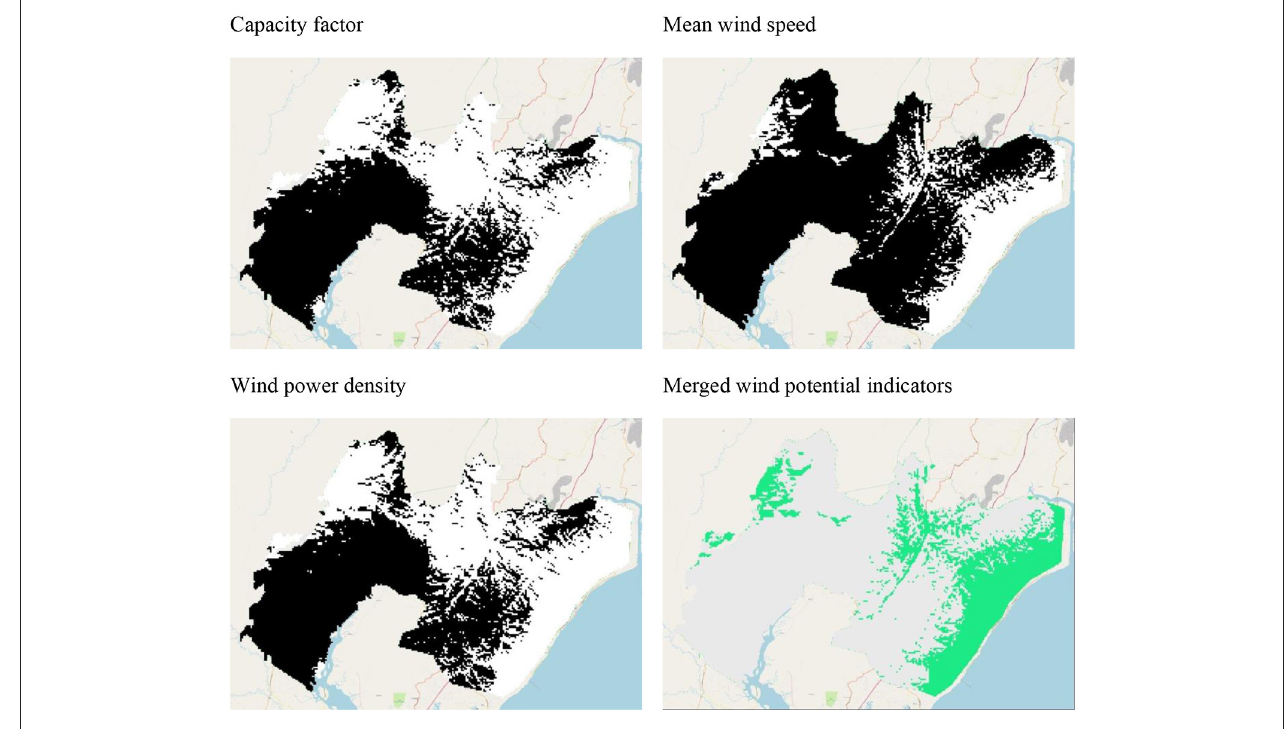
FIGURE 7 | Wind energy potential indicators.